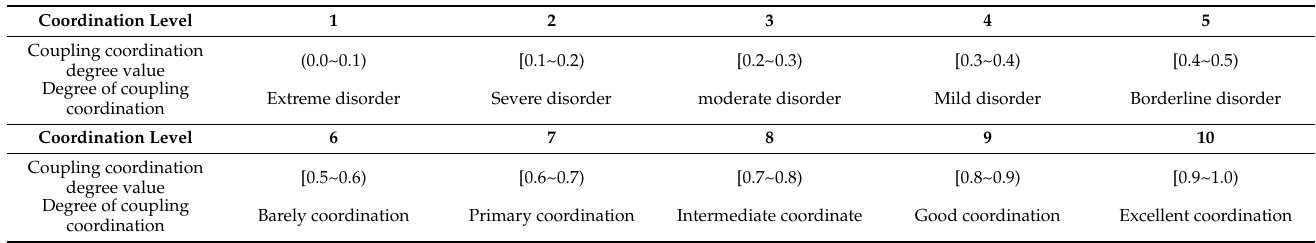
Table 5. Division standard of coupling coordination degree.